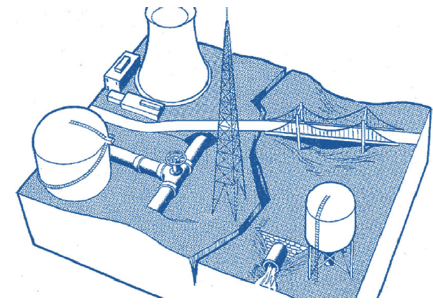
Figure 1: Scheme of lifelines.